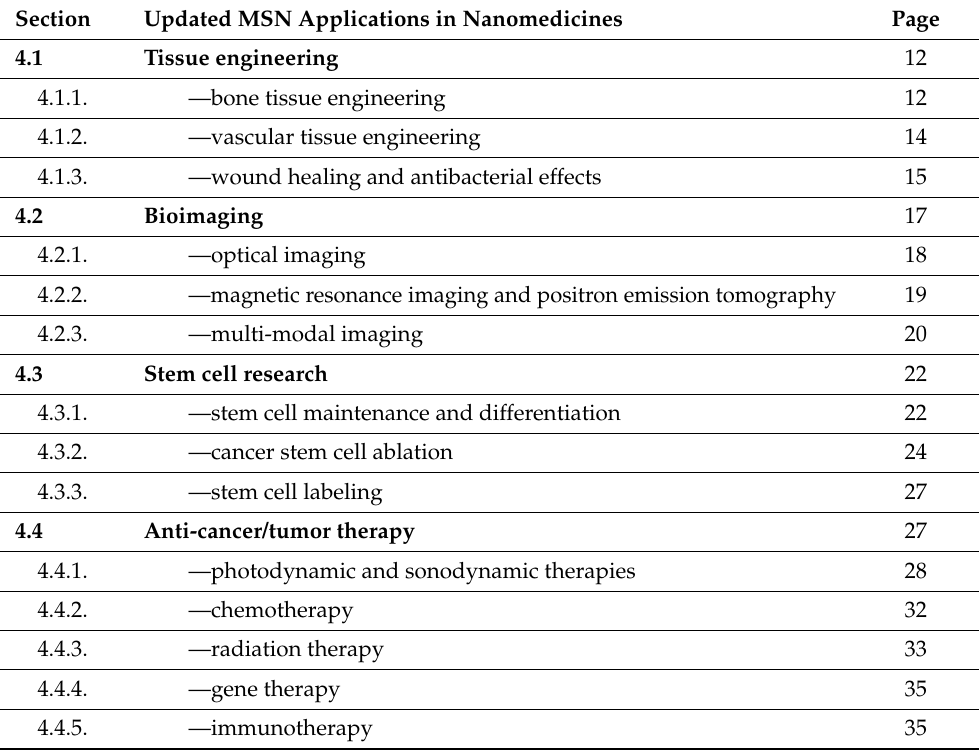
Table 1. Update of MSN applications in nanomedicines. We conducted a literature review and summarized the latest publications regarding MSN applications in tissue engineering, bioimaging, stem cell research, and anti-cancer/tumor